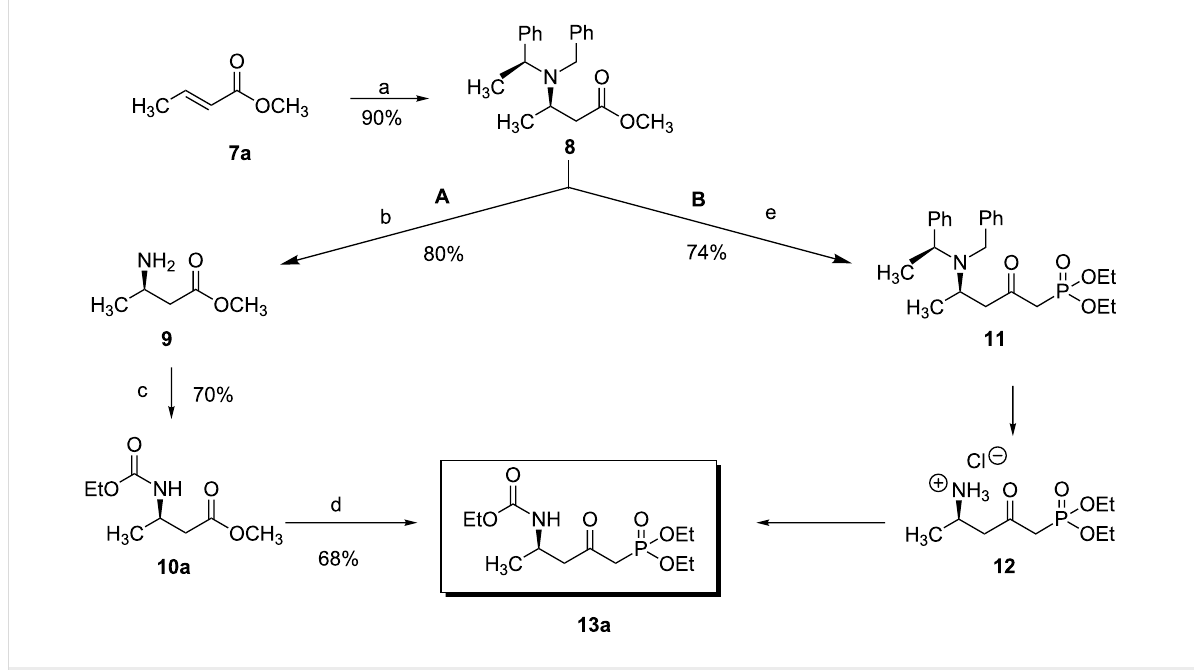
Scheme 4: Possible pathways to obtain phosphonate 13 (a) Davies amine, BuLi, THF, − 78 °C; dr ≥ 95%; (b) H 2 , Pd(OH) 2 /C, MeOH, 60 psi; (c)